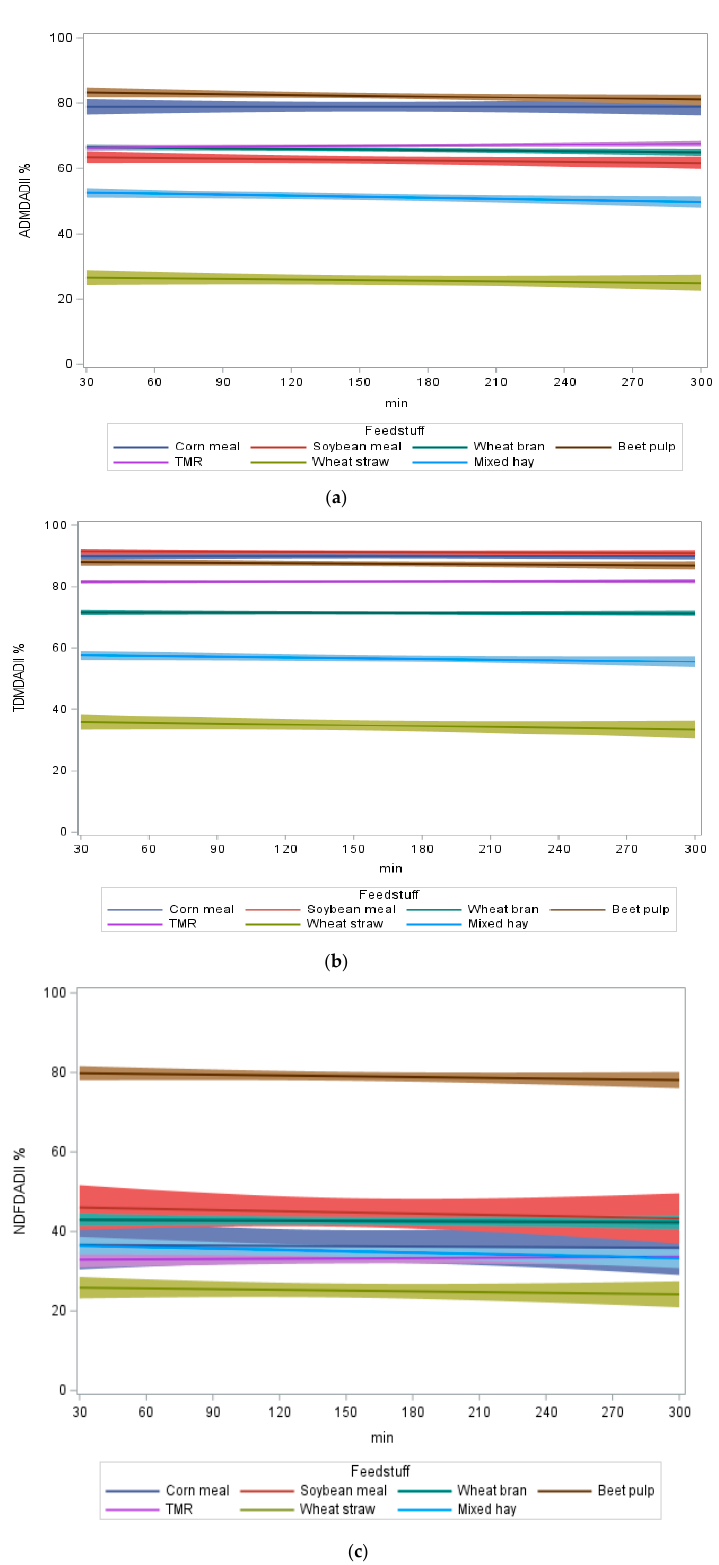
Figure 5. ( a ) Apparent dry matter digestibility (ADMD ADII ) of different feeds and TMR incubated with RF after different storage times with the mean value confidence limits. ( b ) True dry matter digestibility (ADMD ADII ) of different feeds and TMR incubated with RF after different storage times with the mean value confidence limits. ( c ) NDF digestibility (NDFD ADII ) of different feeds and TMR incubated with RF after different storage times with the mean value confidence limits. NDFD ADII showed a greater variability (Table 3). In agreement with other authors [21], the two least fibrous feeds (corn and soybean meal) showed greater and more signif- icant variability than the other feeds and the TMR; however, within each feed, the varia- bility at different storage times was never significantly different. Table 3. Average standard deviation of NDFD ADII of different feeds at different storage time (MSE = 7.98, N = 130).